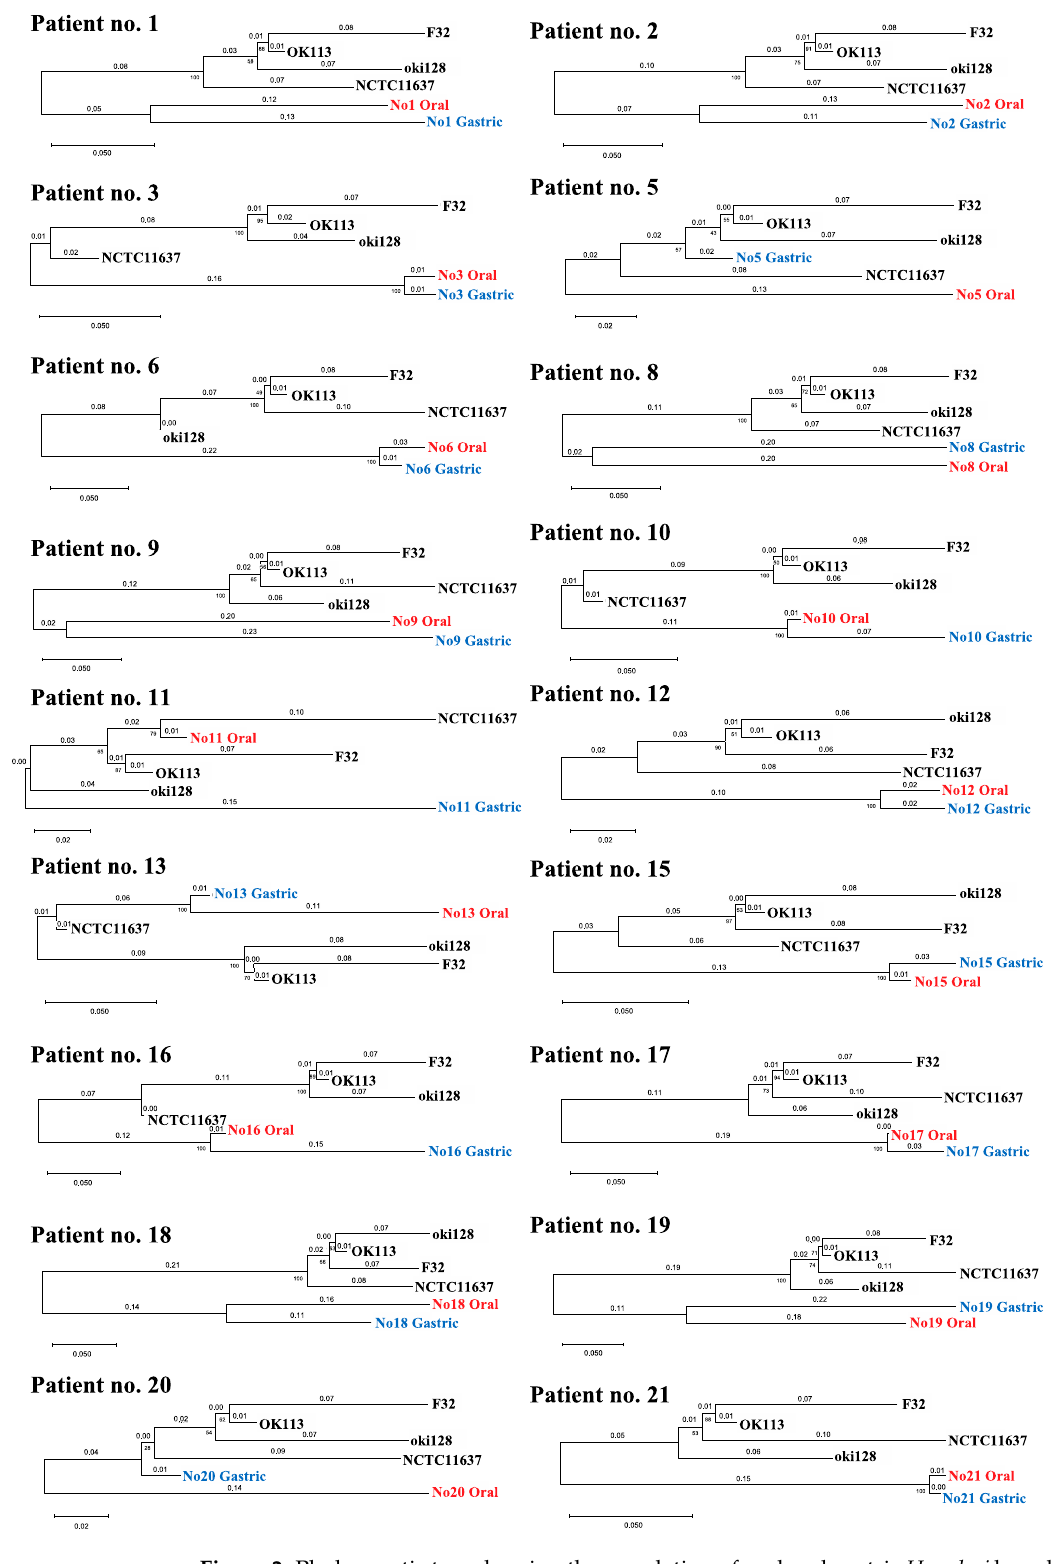
Figure 2. Phylogenetic tree showing the correlation of oral and gastric H. pylori based on sequence arrangements. Phylogenetic tree was created using the samples that obtained a combination of two or more alleles, including patient no. 13. The gene sequences of H. pylori OK113, oki128, and F32 clinical isolates from East Asia were downloaded from the BLAST website. The numbers indicate distances between the strains tested